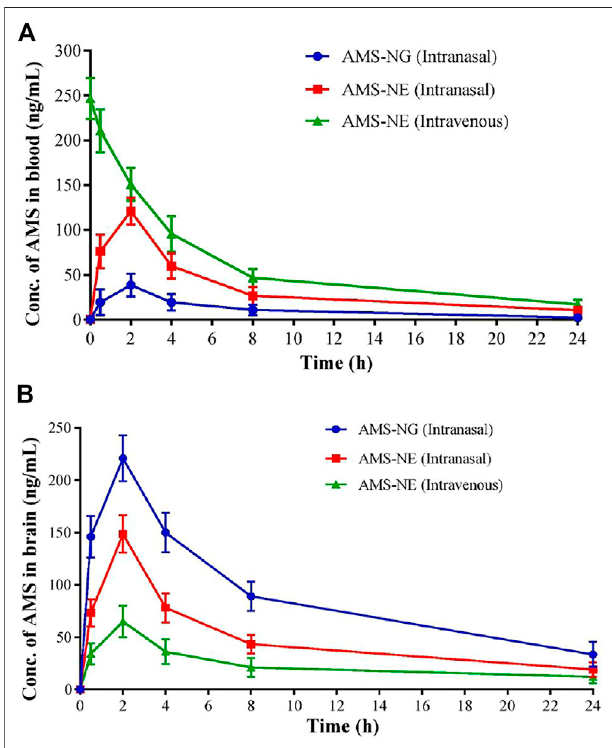
FIGURE 5 | Mean (A) blood, (B) brain concentration-time curve for amisulpride nanogel (AMS-NG) (intranasal), amisulpride nanoemulsion (AMS-NE) (intranasal), and AMS-NE (intravenous) (Gadhave et al., 2021).